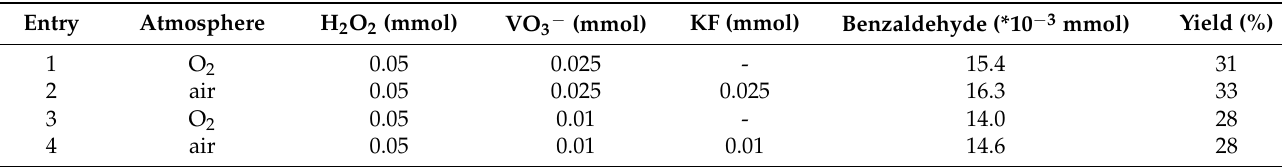
Table 6. Toluene oxidation under air and O 2 atmosphere in a biphasic system PhCH 3 -H 2 O (V = 20 mL; PhCH 3 :H 2 O 1:1 v/v), pH = 1, after 24 h, at 60 °C.